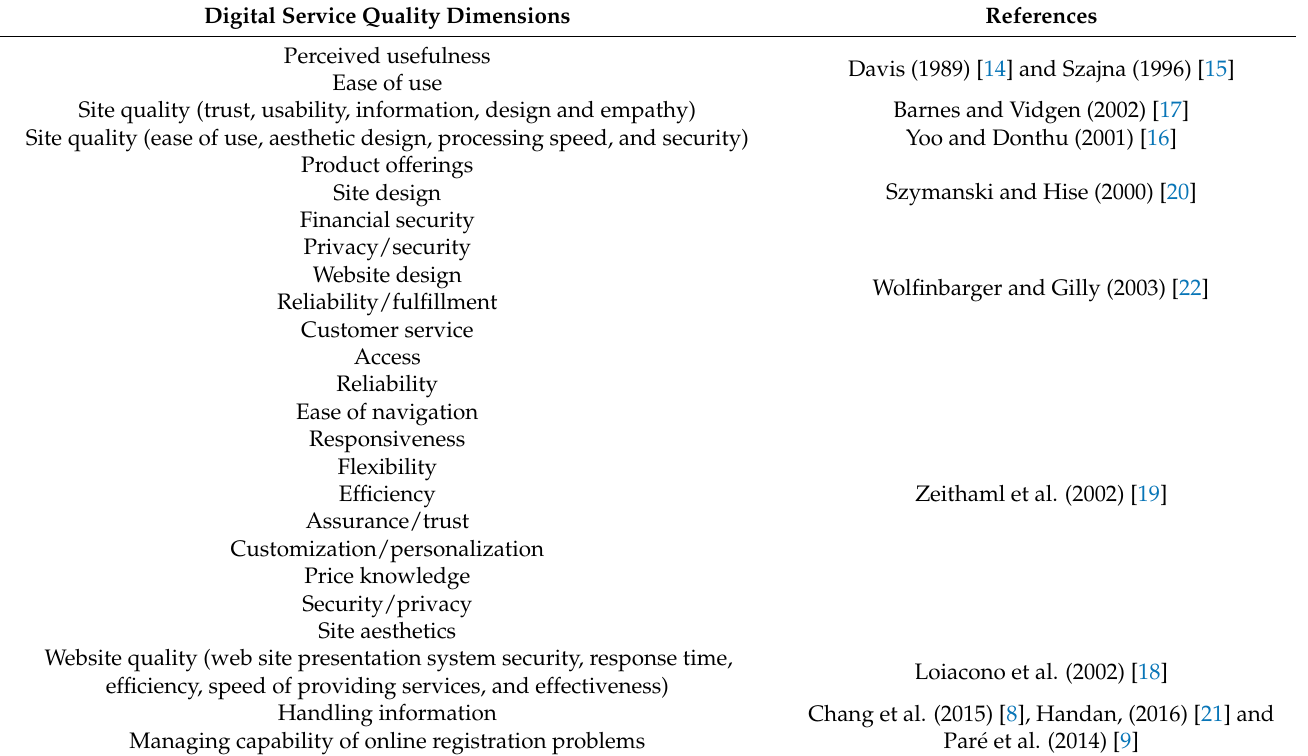
Table 1. Digital service quality